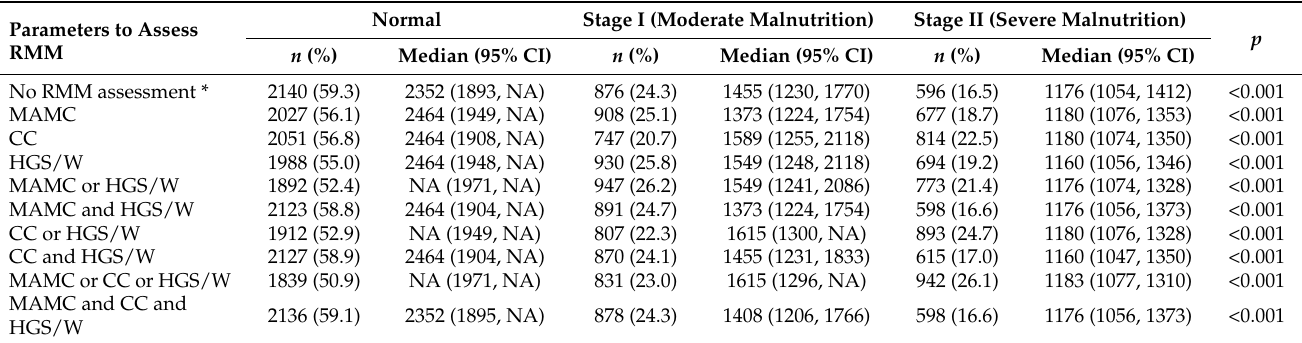
Table 1. Median Survival Days of the Study Population Stratified by GLIM Grade Using Different Parameters for RMM Assessment.